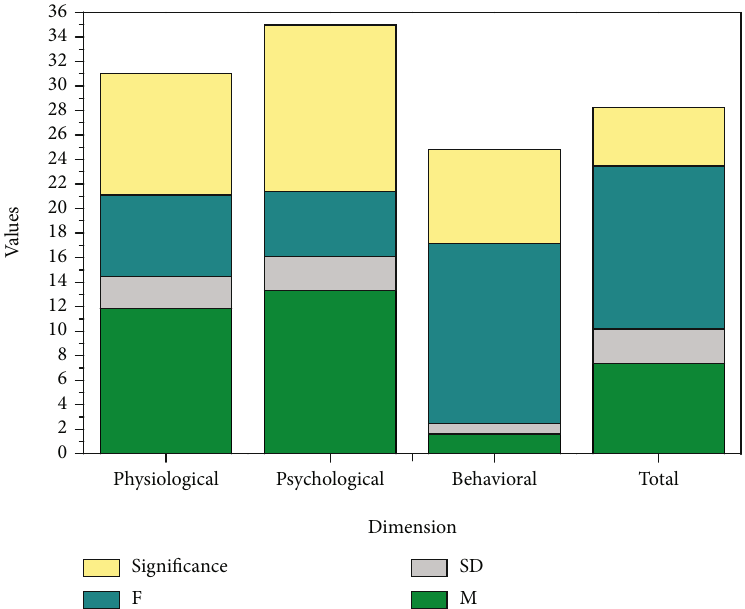
Figure 6: Comparison of college students in higher education institutions in terms of the psychological stress